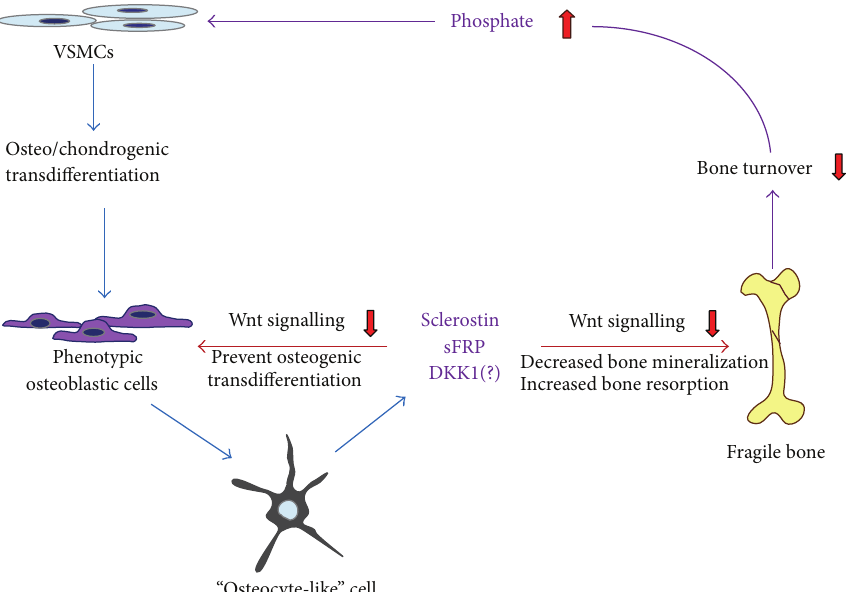
Figure 5: Calcified vessels on bone turnover in chronic kidney disease (CKD). The phenotypic osteoblast/osteocyte in calcified vessels may secrete sclerostin (SOST), secreted frizzled-related protein (sFRP), and Dickkopf-related protein 1 (DKK1), which prevent further calcification of the affected vessel. The secreted SOST and sFRP will process autocrine or paracrine effects to inhibit Wnt signaling effects on osteogenic transdifferentiation of VSMCs, which will prevent further calcification of the vessel wall. As the SOST and sFRP secreted from calcified vessel are released into circulation, they may inhibit Wnt signaling in osteoblast in the bone. This inhibition of bone osteoblasts reduces bone accretion and turnover, resulting in a fragile bone, which may also contribute elevated serum inorganic phosphates. In addition, DKK1 enhances RANKL levels, and the increased RANKL :OPG ratio activates osteoclast activity, leading to the increase of bone resorption.